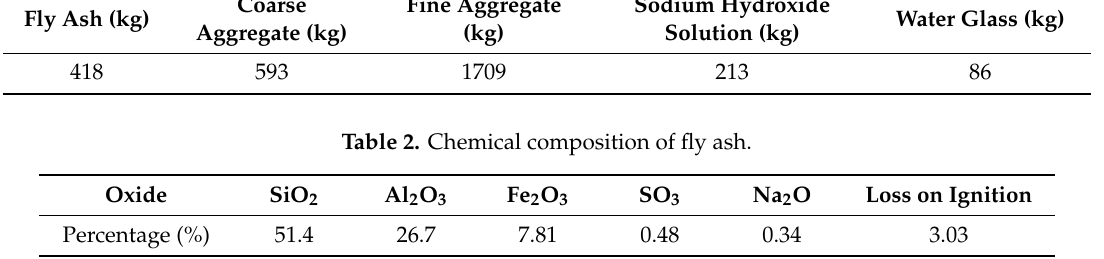
Table 3. Properties of fibers.